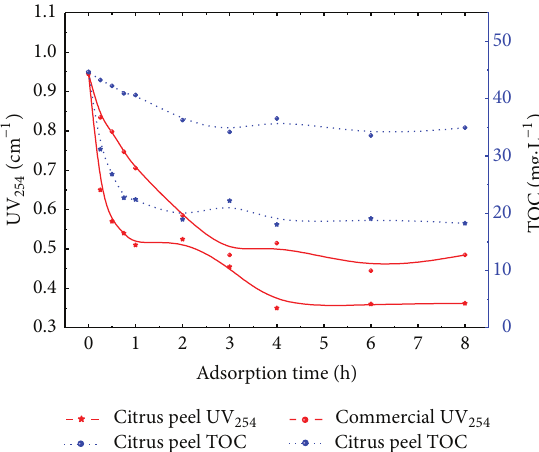
Figure 7: Adsorption property of activated carbon.